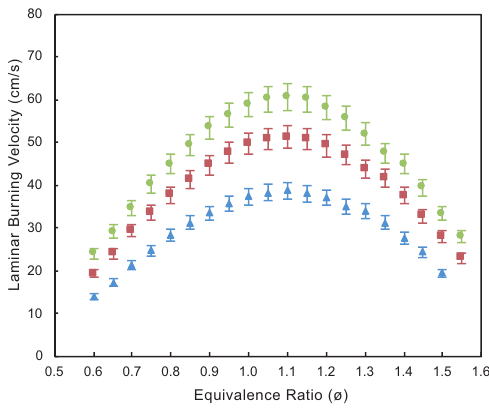
Figure 9. Laminar burning velocities for flames of MTHF/air mixtures at 0.101 MPa. Circles: T gas , unburned = 298 K, squares: T gas , unburned = 358 K, triangles: T gas , unburned = 398 K (adapted from De Bruycker et al.